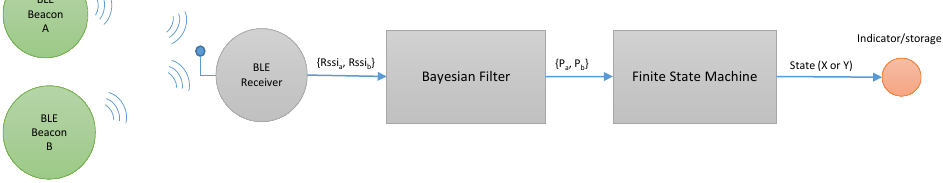
Figure 5. An example of a virtual fence formed by placing two BLE beacons in sequence and using a BLE wearable receiver to notify the user when a change of area occurs.